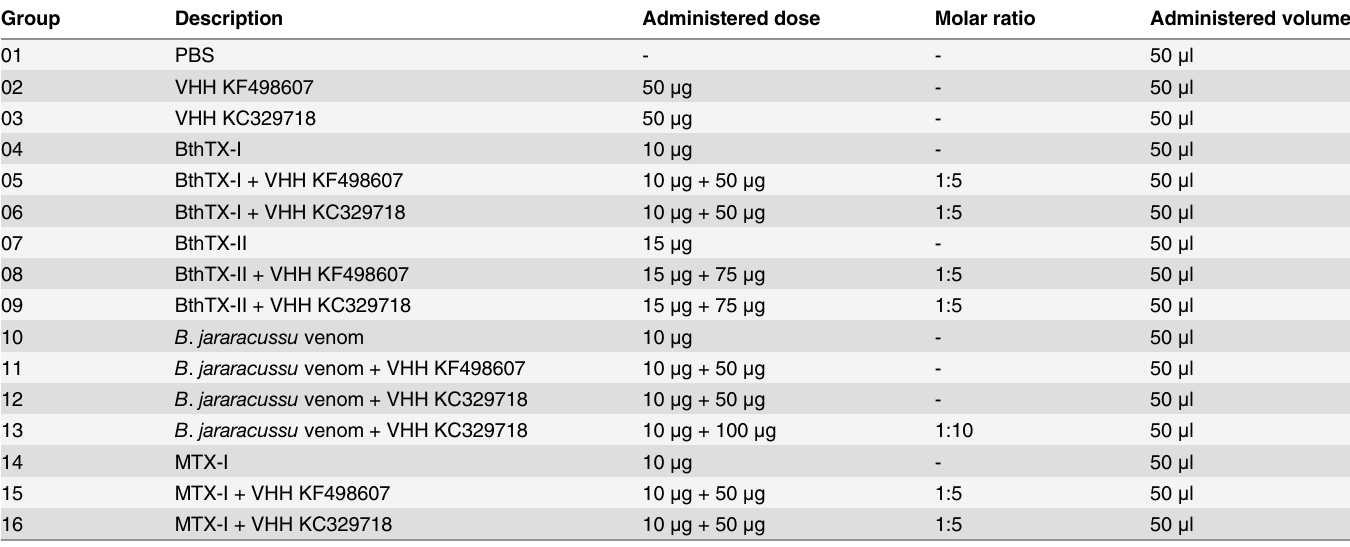
Table 1. Groups of mice subjected to in vivo neutralization